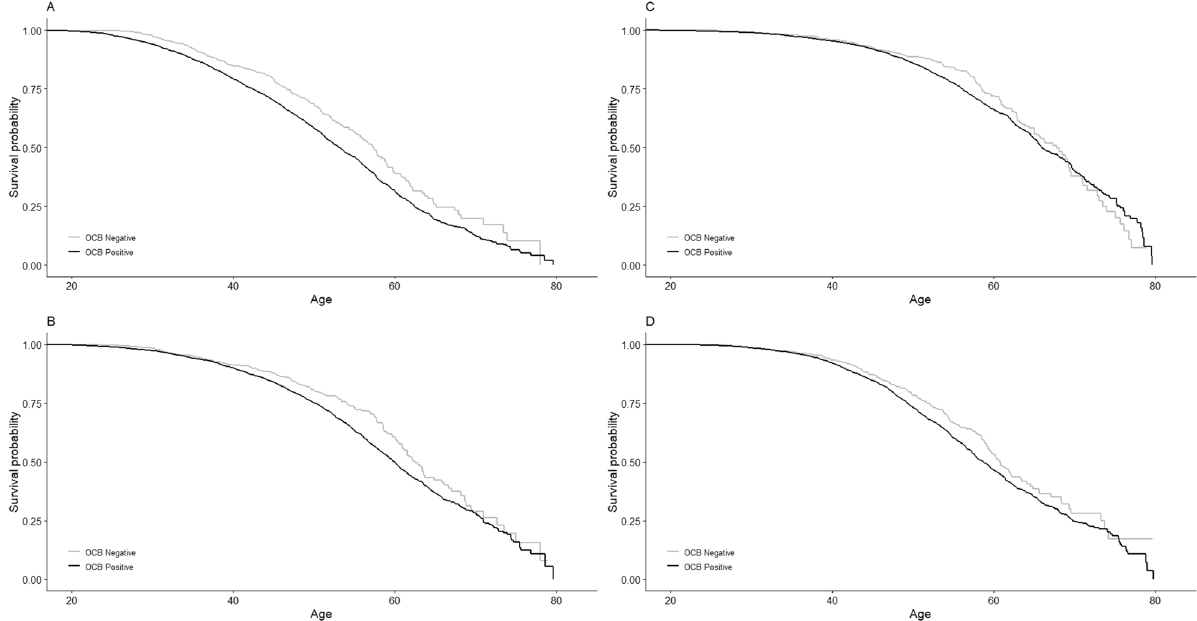
Figure 1. Kaplan–Meier plots (cumulative hazard functions) of reaching EDSS milestones from birth in OCB- positive (black line) and OCB-negative (grey line): ( A ) EDSS 3, ( B ) EDSS 4, ( C ) EDSS 6. ( D ) Kaplan–Meier plot of conversion to SP in OCB-positive (black line) and OCB-negative (grey